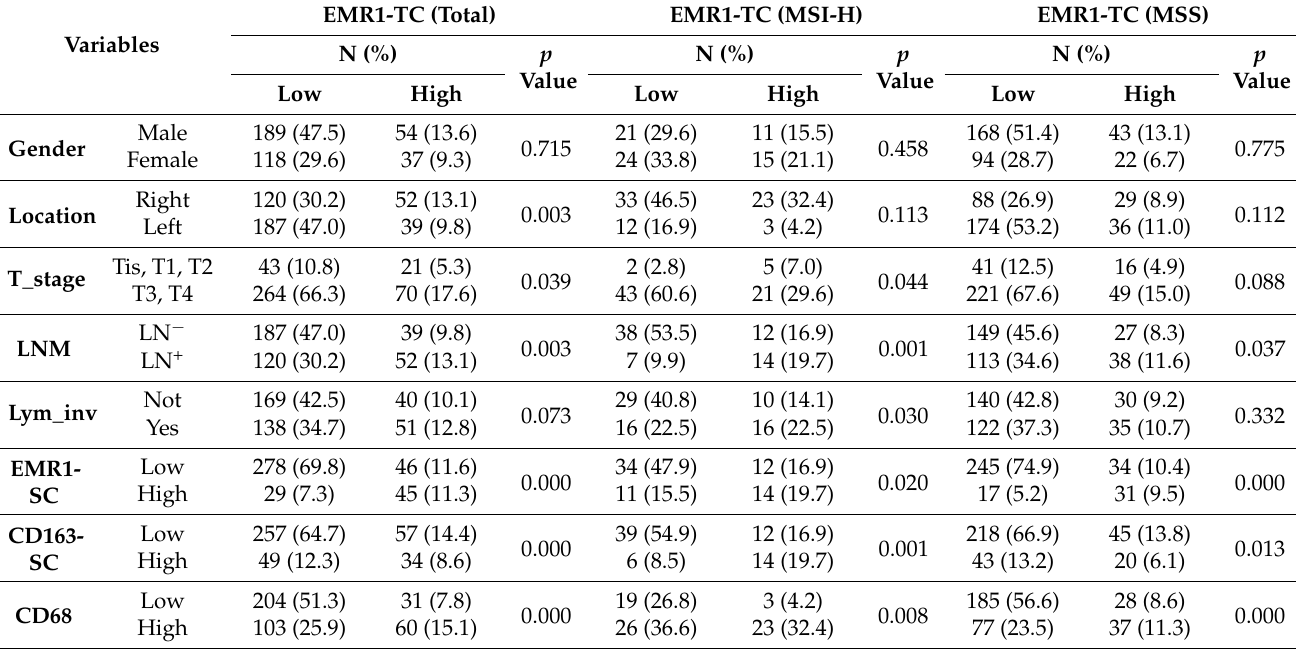
Table 1. Correlation between EMR1-TC and clinicopathologic parameters in MSI-H and MSS CRC.